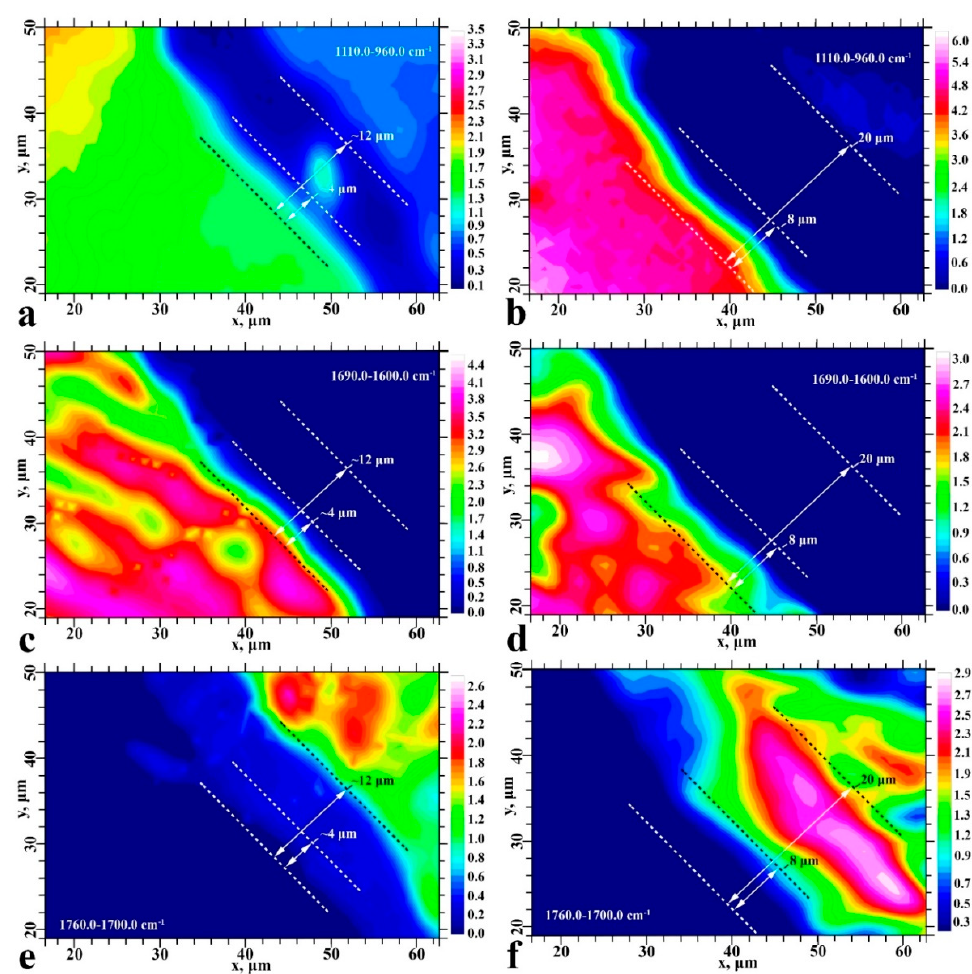
Figure 3. Chemical imaging maps for type I ( a , c , e ) and type II ( b , d , f ) specimens. Colour-coded univariate images of the mineral component of apatite dentine ( a , b ), amide I ( c , d ) and ester (-COOCH 3 ) ( e , f ).